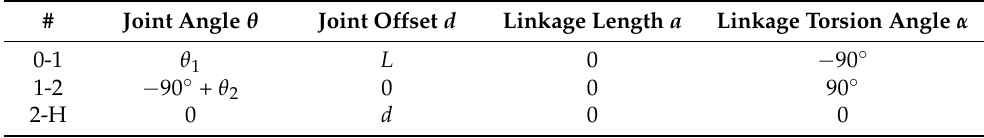
Table 3. D-H parameters of surgical manipulator.